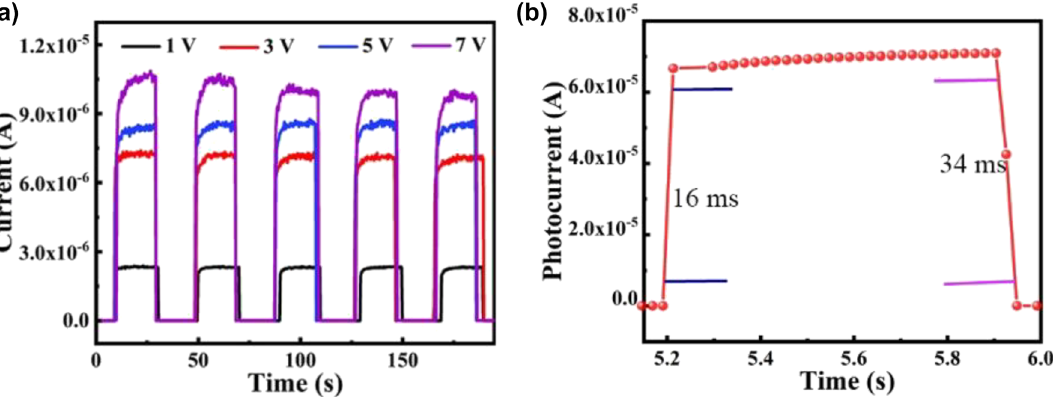
MW hybrid device 3